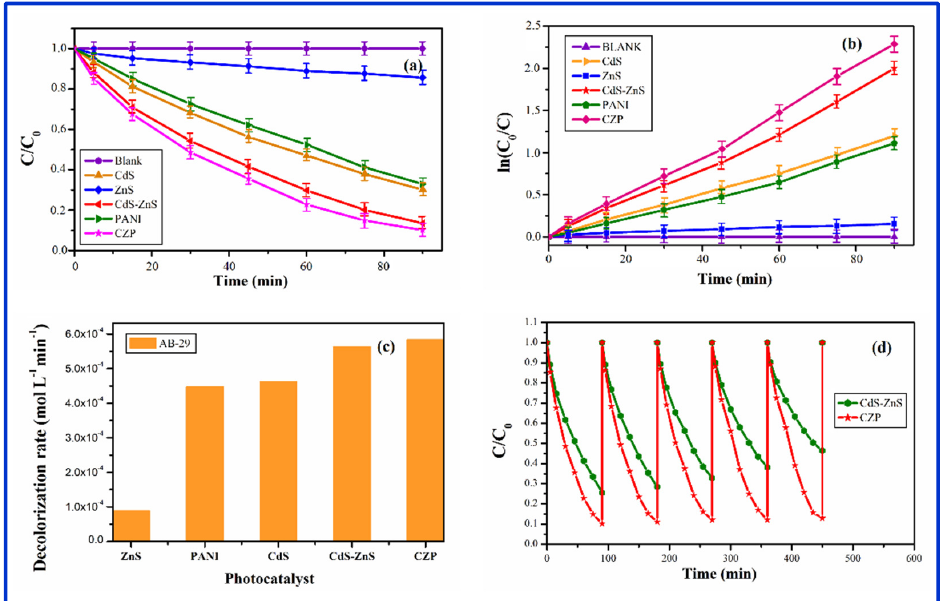
Figure 10. ( a ) Change in concentration of AB-29 with time in the presence and absence of CZP in comparison to PANI, CdS and ZnS nanoparticles and CdS-ZnS nanocomposite ( b ) Change in concentration of AB-29 with time in the presence and absence of CZP in comparison to PANI, CdS and ZnS nanoparticles and CdS-ZnS nanocomposite ( c ) The decolorization rate of AB-29 in the presence of synthesized CZP in comparison to PANI, CdS and ZnS nanoparticles and CdS-ZnS nanocomposite ( d ) Stability and recycle of CdS-ZnS nanocomposite embedded in PANI (CZP), in comparison to free CdS-ZnS nanocomposite without PANI.